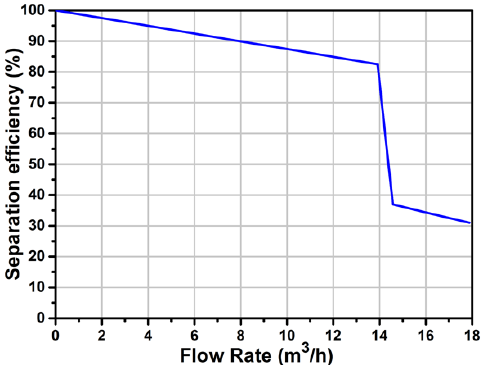
Figure 14. Gas separation efficiency of rotary gas separator (RGS) and the annulus at pump intake pressure of 200 psi [123].